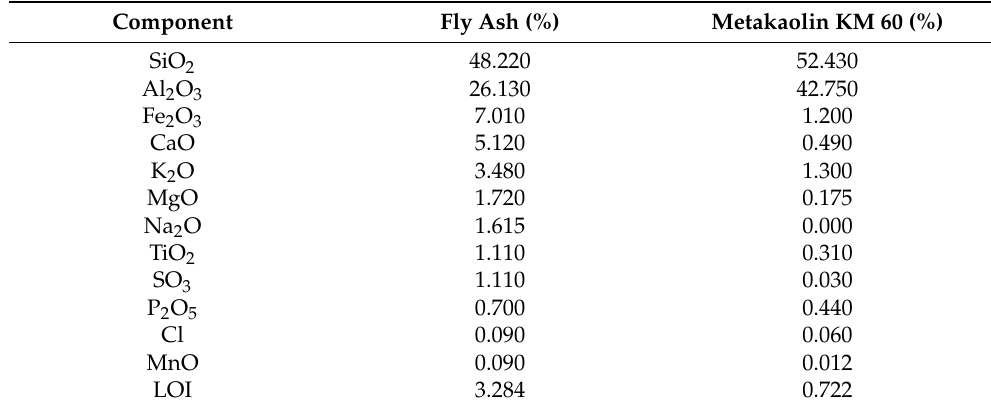
Table 1. Chemical composition of fly ash and metakaolin determined by X-ray fluorescence analysis, wt.% [29].